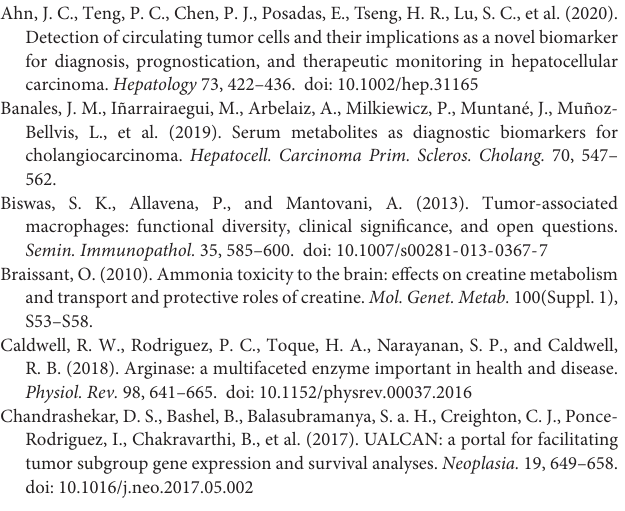
Supplementary Figure 6 | High concentrations of ammonia inhibits the proliferation of cancer cells. (A) Colony formation ability of NCM460, HCT116 and MCF-7 under different concentrations of NH 4 Cl. (B–D) Colony number quantification of NCM460, HCT116, and MCF-7 under different concentrations of NH 4 Cl by Image J. (E,F) Proliferation of PLC/PRF/5 and HepG2 cells cultured under 0, 5, 10 or 20 mM NH 4 Cl for 3 days. Values are the means ± SD of three independent experiments. * p < 0.05; ** p < 0.01, *** p < 0.001, **** p < 0.0001. Supplementary Figure 7 | Urea cycle protect cancer cells from high concentrations of ammonia. (A) Colony formation ability of PLC/PRF/5/shScr and PLC/PRF/5/shCPS1-1, HepG2/shScr and HepG2/shCPS1-1 under control or 10 mM NH 4 Cl. (B,C) Colony number quantification of PLC/PRF/5/shScr and PLC/PRF/5/shCPS1-1, HepG2/shScr and HepG2/shCPS1-1 under control or 10mM NH 4 Cl by Image J. (D) Colony formation ability of MHCC97H/Vector and MHCC97H/CPS1, HCT116/Vector and HCT116/CPS1 under control or 10mM NH 4 Cl. (E,F) Colony number quantification of MHCC97H/Vector and MHCC97H/CPS1, HCT116/Vector and HCT116/CPS1 under control or 10 mM NH 4 Cl by Image J. Values are the means ± SD of three independent experiments. * p < 0.05; ** p < 0.01, *** p < 0.001, **** p < 0.0001. Supplementary Table 1 | Characteristics of serum samples from healthy controls, HBV, HBV positive cirrhosis, HCV, HBV positive HCC patients, and metastatic HCC